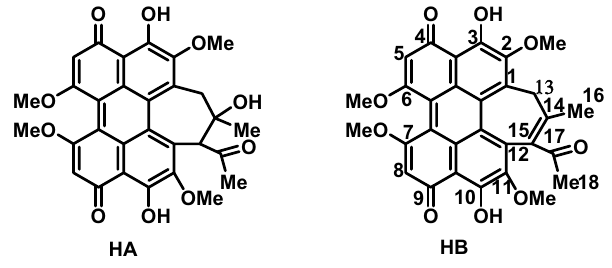
Fig. 1. The chemical structures of HA and